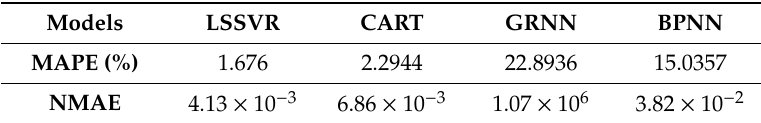
Average MAPE and average NMAE values of machines learning models without attribute selection.